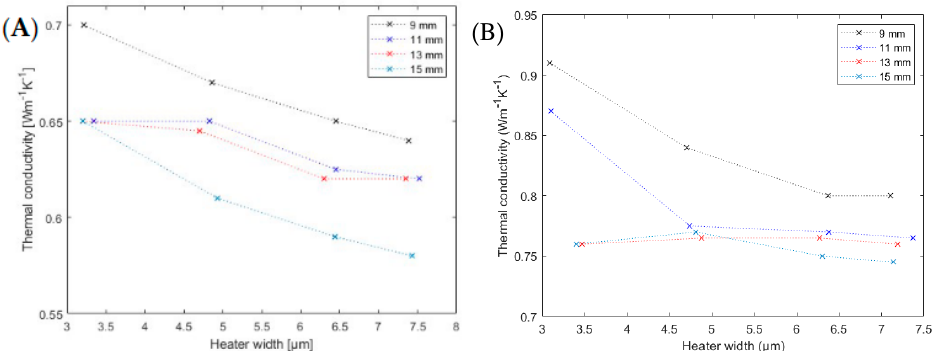
Figure 10. Measured thermal conductivity of ( A ) 500 nm and ( B ) 1000 nm thin SiO 2 films. The different colors correspond to different heater lengths as indicated in the inset.